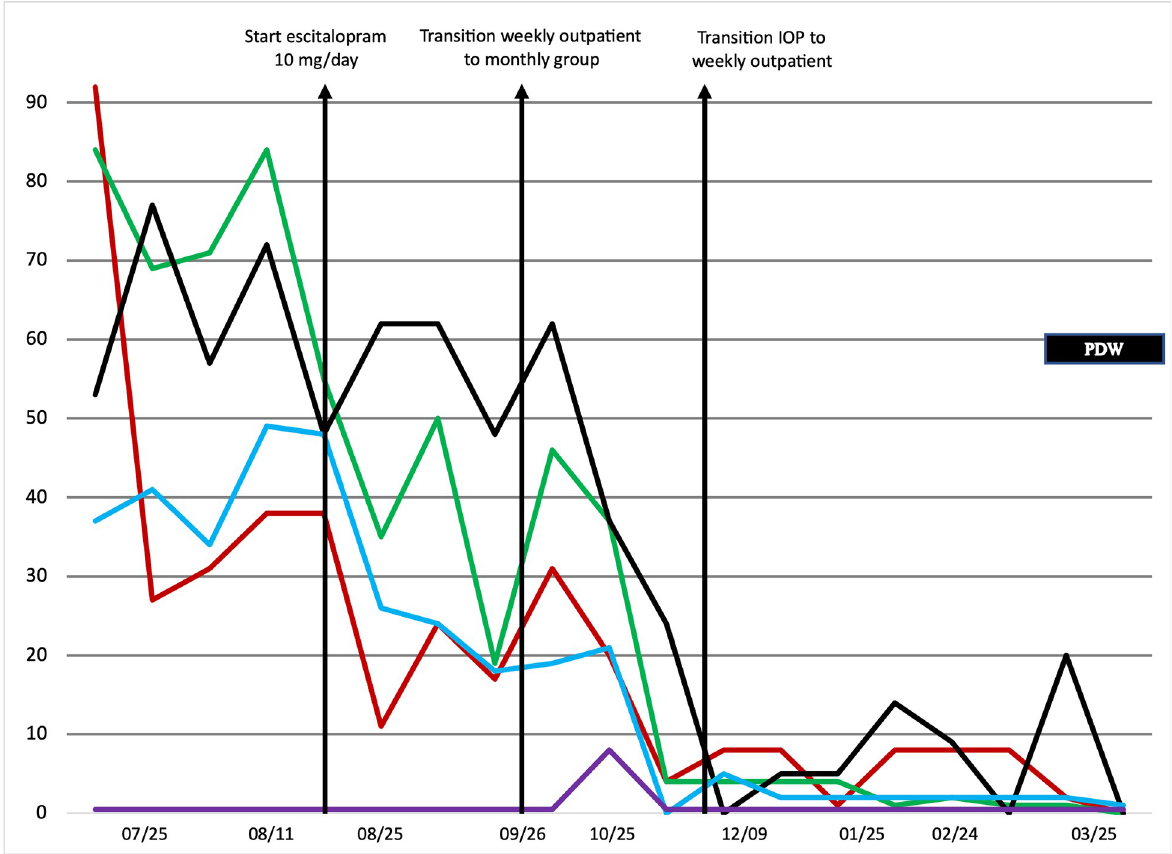
Fig 1. De-identified example of MBC data display for treatment team meeting. Scores are scaled as a percentage of the maximum score for each measure (see Table 1). Lines indicate scores on the following scales: Mood: red (Short Mood and Feelings Questionnaire); Anxiety: green (Screen for Child Anxiety Related Disorders); Sleep: black (Pittsburgh Sleep Quality Index); Mood Lability: blue (Children’s Affective Lability Scale); Substance Use: purple (Car, Relax, Alone, Forget Friends, Trouble). The black box labeled “PDW” is an example of a “flag” based on responses to the ASQ at the most recent assessment, in this case indicating endorsement of passive death